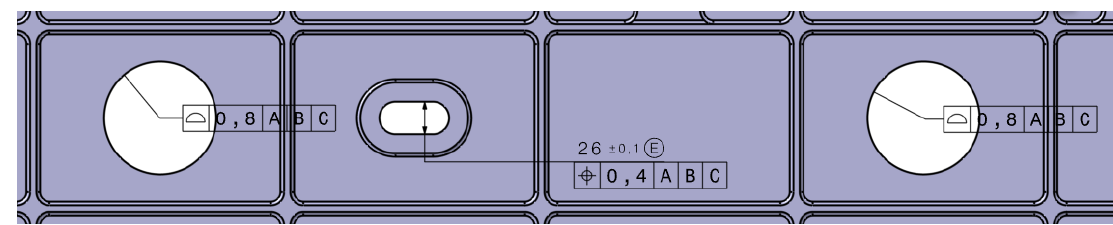
Figure A2. Tooling interface in ASME model.